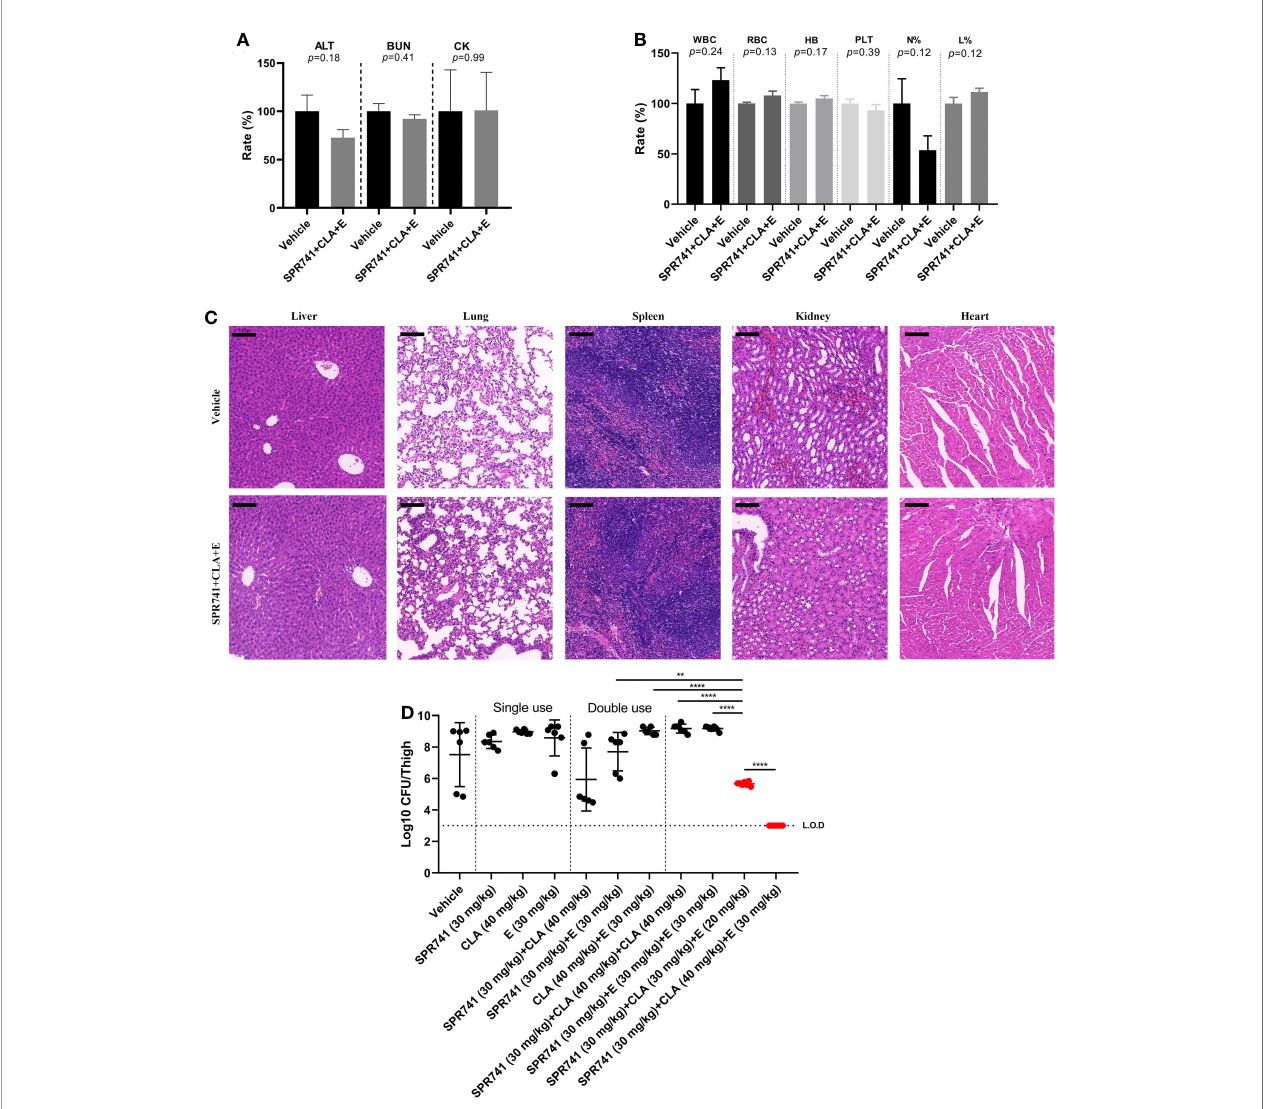
FIGURE 6 | SPR741 combined with CLA and E displayed ef fi cacy in a neutropenic murine thigh infection model, without detectable obvious toxicity. Biochemical routine examination (A) , blood cell analysis (B) , and hematoxylin-eosin staining (C) (from left to right: liver, lung, spleen, kidney and heart tissues. Scale bar: 100 µm) after subcutaneously administrating 30 mg/kg SPR741, 30 mg/kg E, and 40 mg/kg CLA in ICR mice. Saline with 1% DMSO was used as control. (D) As compared to mono or double antibiotics, SPR741 had potent synergy in triple combination with CLA and E, on reducing the bacterial load in PDR KP LH2020-related murine thigh infection model. Horizontal dotted line indicates the detection limit (LO.D). And the mono/double/triple dose treatment was separated using a vertical dotted line. The red dots indicate the triple treatment group of SPR741+CLA+E, *p<0.05; **p<0.01; ***p<0.001;